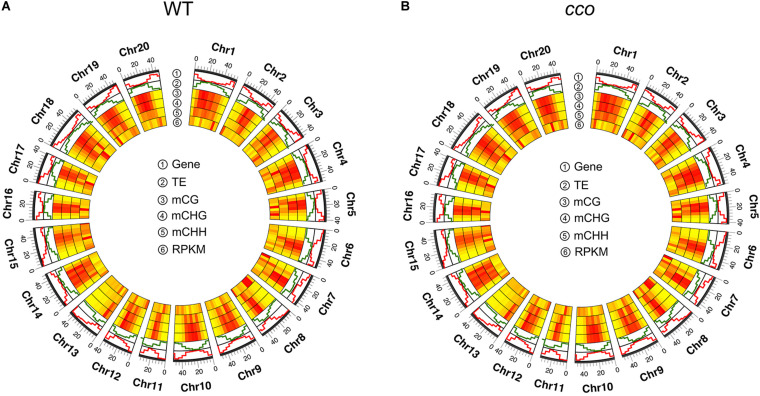
A circle plot of gene density, transposon density, DNA methylation level, and the transcript level for the WT (A) and the cco mutant (B). Gene indicates “gene density;” TE indicates “transposon density;” mCG, mCHG, and mCHH indicate the methylated cytosine level in each context, respectively; RPKM (reads per kilobase million) indicates “gene expression level.” Data was plotted in 5-Mb windows on all soybean chromosomes. Bars with color from yellow to red indicate the methylation level or gene expression level from low to high, respectively. Pictures were drawn by TBtools.